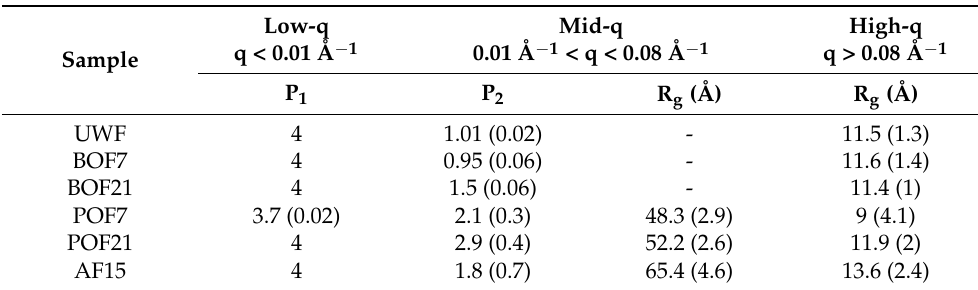
Table 5. Effects of modification on the scattering parameters. Uncertainties for each parameter are included in